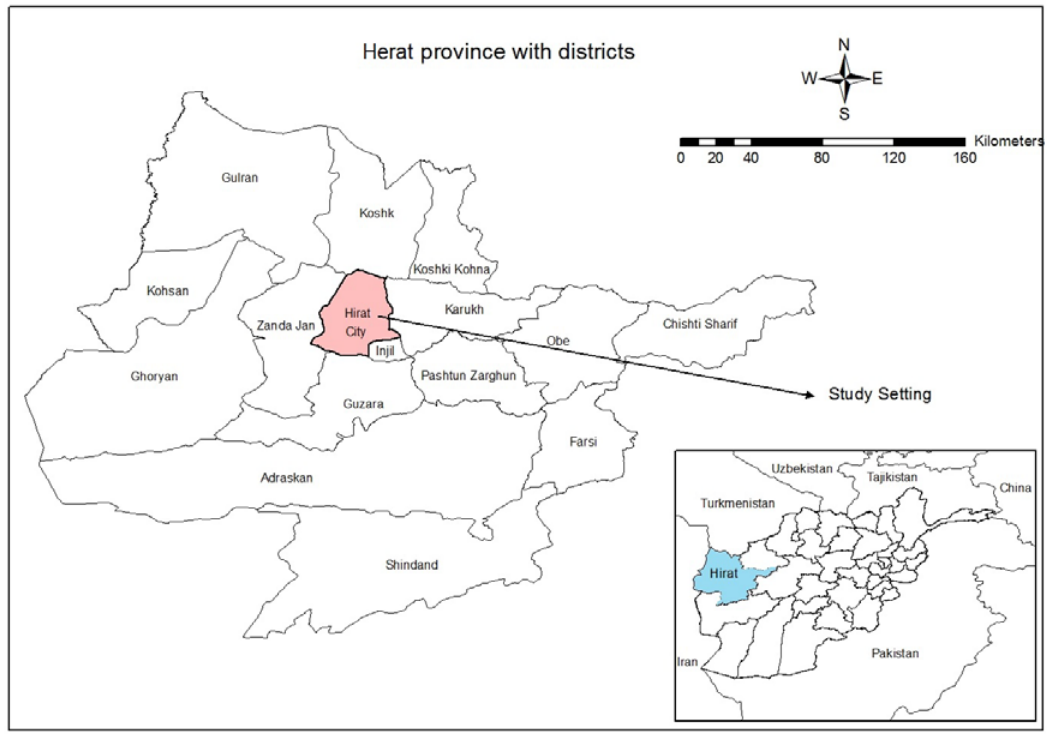
Figure 1. Location of study setting in western province of Herat,